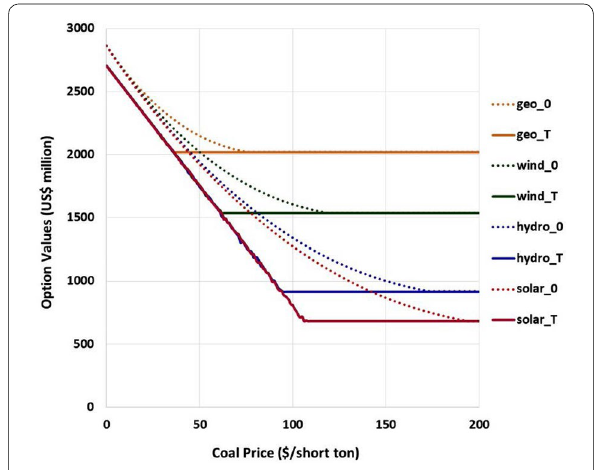
Fig. 1 Option values of various renewable energy sources. Note geo_0, geo_T, wind_0, wind_T, hydro_0, hydro_T, solar_0, and solar_T are option values for investment in geothermal, wind, hydropower, and solar PV at the initial (0) and terminal ( T ) period of invest- ment (see Additional file 1: Table S3 for the simulation result)